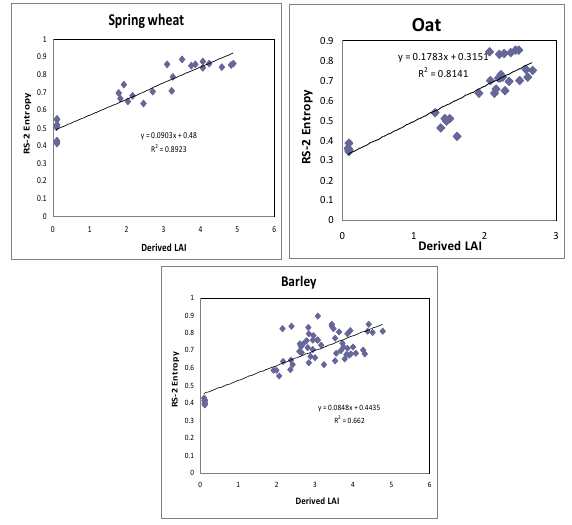
Figure 1. Relationship between entropy and optically derived